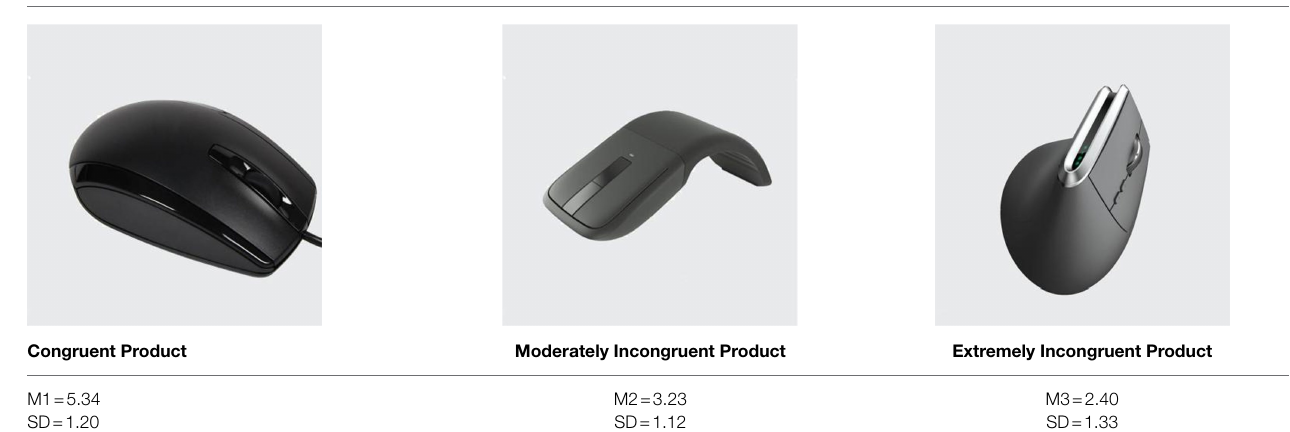
TABLE 6 | Pretest of computer